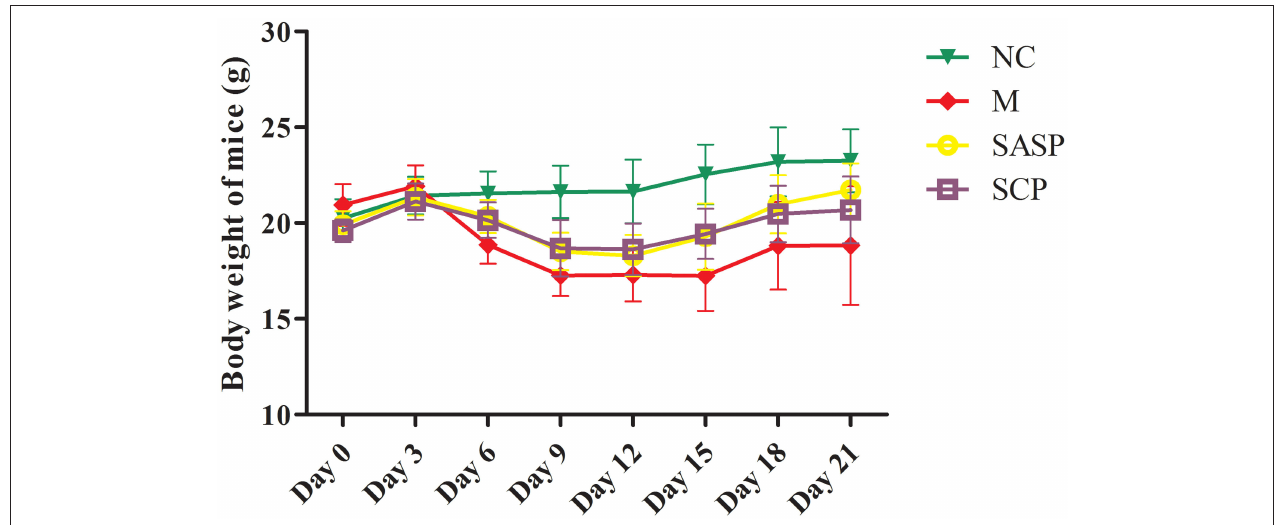
FIGURE 1 | Effects of SCP on body weight. NC, control group; M, DSS group; SASP, positive drug group; SCP, S. chinensis polysaccharide group. The values are expressed as means ± S.D.